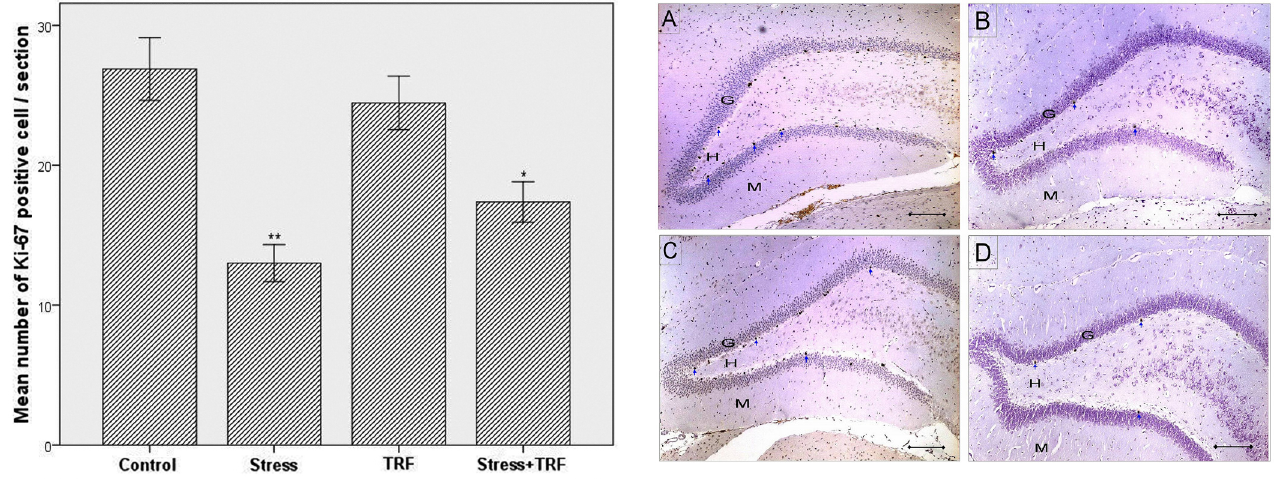
FIGURE 2 – Effects of stress, tocotrienol rich fraction (TRF) supplementation and combination of stress and TRF on the number of Ki-67 immunopositive cells. Value represents mean ± SEM. * & ** indicate significantly different from the control at p < 0.01 and p < 0.001 respectively.